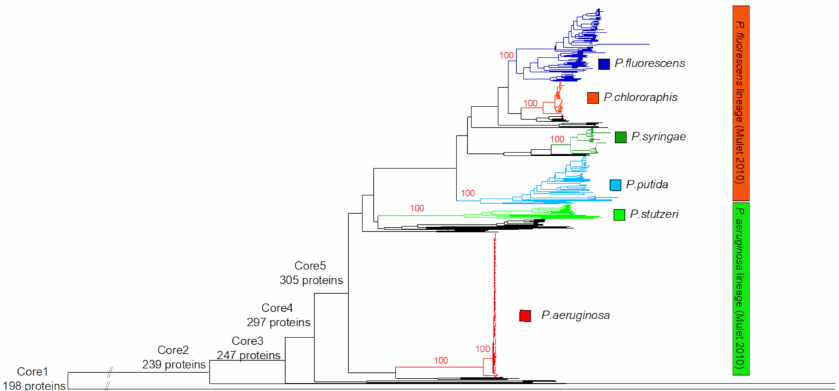
Figure 2. The phylogenomic neighbor-joining tree of the 494 complete proteomes. The tree was based on 198 core proteins (core set 1), using the Kimura model and 500 bootstrap values. The various genus core sets are indicated on the